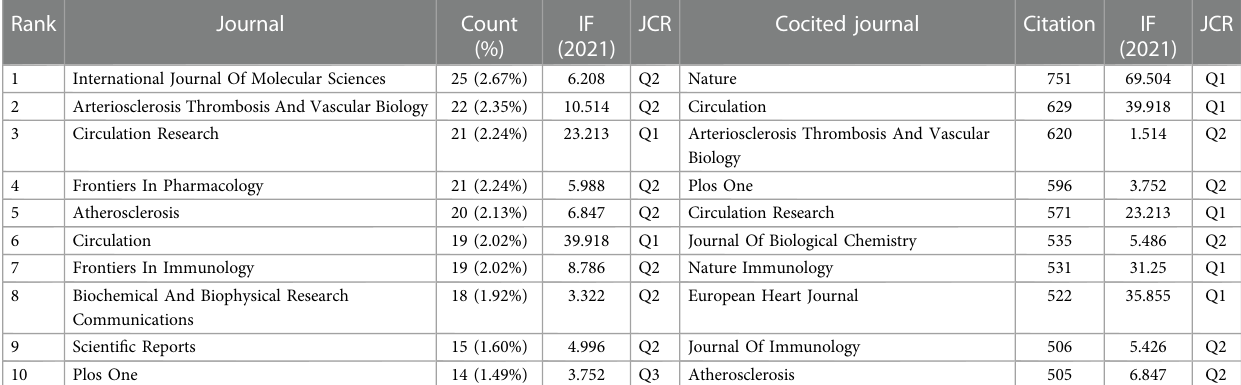
TABLE 4 Top 10 journals and cocited journals related to “ in fl ammasome AND atherosclerosis ”